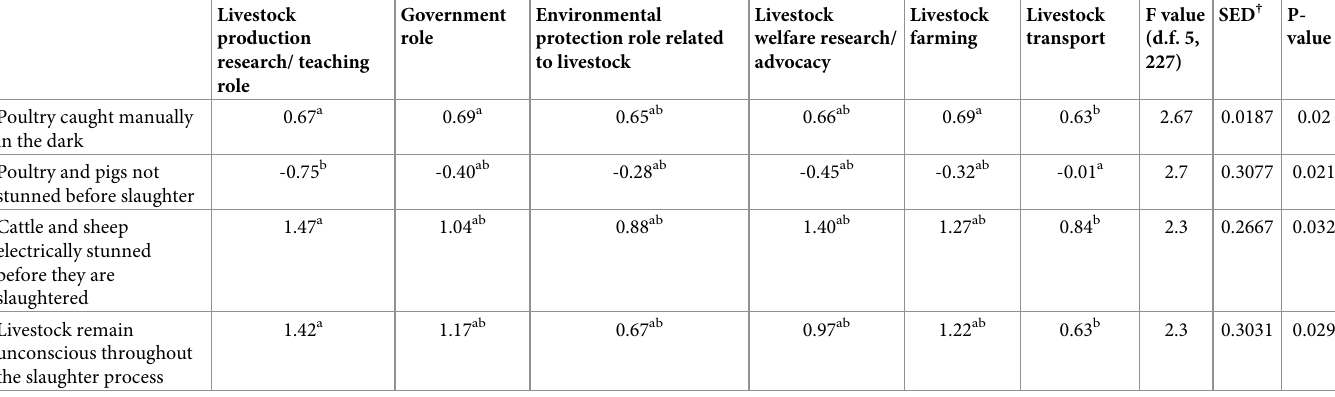
Table 5. Significant (P < 0.05) effects of type of industry involvement of stakeholders, who were stakeholders in the animal transportation and slaughter sectors, on the mean utility values of different levels, which measure the strength of preference for animal welfare. High values indicate high acceptability on animal welfare grounds. There were no veterinary or livestock slaughterer respondents, and a small number of respondents that did not align themselves with any of the stated industries were